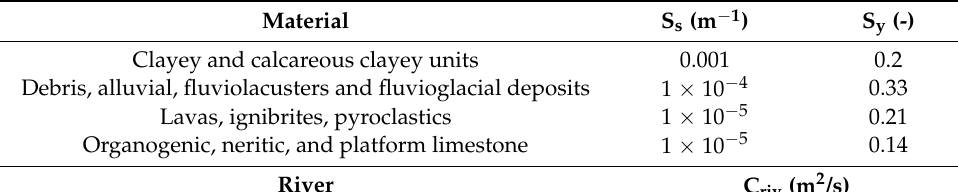
Table 2. S s and S y depending on the geologic material (upper panel), and C riv gained after the calibration procedure (lower